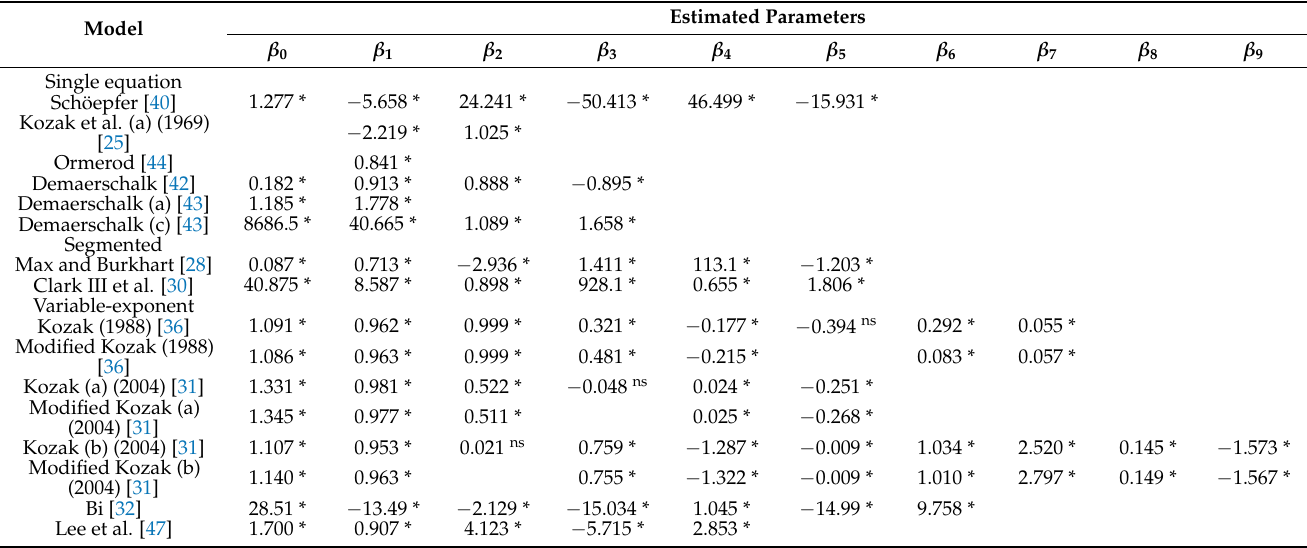
Table 6. Parameters estimated in the adjustment of the taper models without stratification of Tectona grandis L. f. data, central-west region,